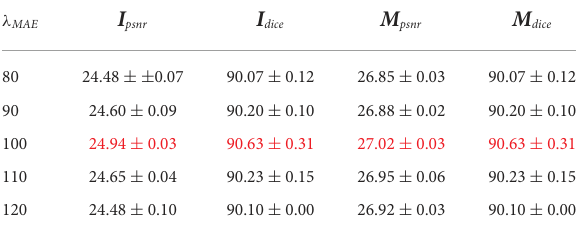
TABLE 4 Ablation study of λ MAE in L x loss function for plant RGB image